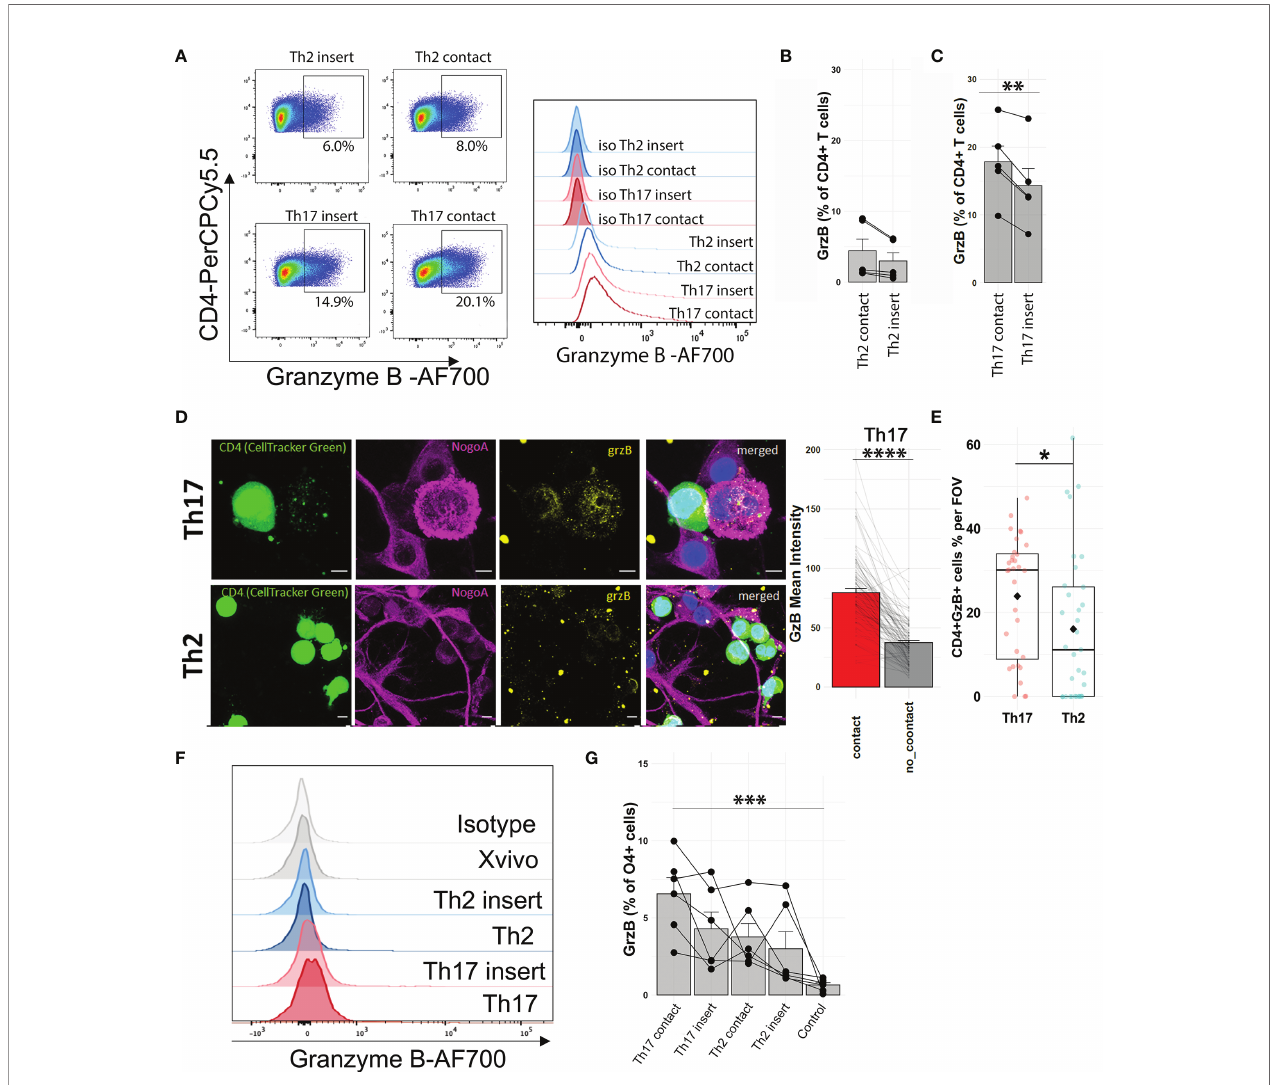
FIGURE 4 | Direct contact with Th17-polarized cells is associated with detection of granzyme B in OLs. (A) Representative FACS pseudocolor dot plots and histogram overlay with isotype and (B, C) quanti fi cation of the proportion of CD4 + T cells expressing granzyme B in (B) Th2-polarized cells or (C) Th17-polarized cells after 16 h of coculture with human primary OL separated by a permeable membrane (insert) or in direct contact, no activation with PMA-ionomycin. Wilcoxon matched-pair test (B) or paired t-test (C) , n = 5 different OL preps and 5 T cell donors. (D) Representative immuno fl uorescent images of polarized T cell – OL coculture after 4 h and quanti fi cation of granzyme B (mean intensity) in areas of Th17-polarized cells in direct contact (red) or not (gray) with OL, n = 3 different OL preps and 4 T cell donors, total of 100 cells (25 cells/donor). (E) Quanti fi cation of granzyme B + CD4 + cells (percentage), scale bar = 5 m m, n = 3 preps, n = 4 donors, Wilcoxon test, diamond = mean. (F) Representative FACS histogram and (G) quanti fi cation of the percentage of O4+ cells expressing granzyme B after 16h coculture with human primary OLs, Friedman test with Dunn ’ s method, n = 6 OL preps, and 6 T cell donors. **p < 0.01, ***p < 0.001, ****p <